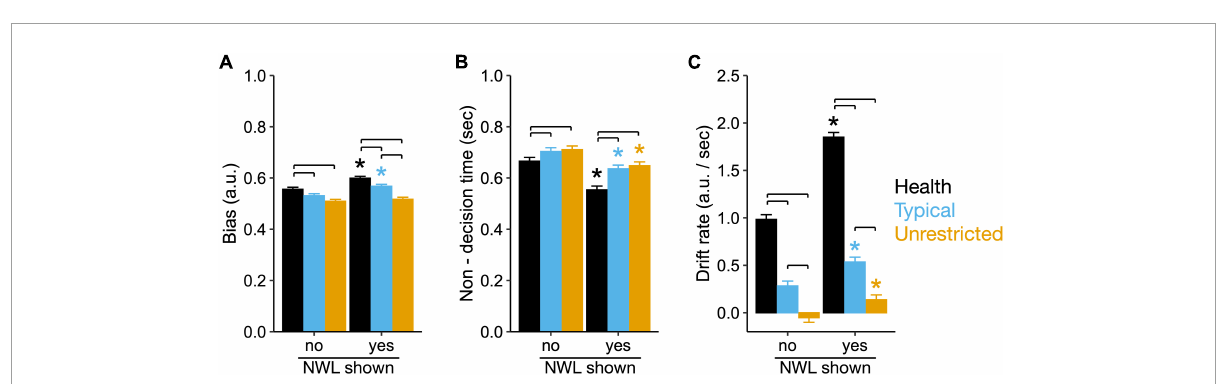
FIGURE5 Eating contexts determine the effect of showing nutrient warning labels (NWL) on the bias, non-decision time, and drift rate during food choice. (A) Bias, (B) Non-decision time, and (C) Drift rate derived from a drift-diffusion model (DDM) considering healthy food choices as the upper boundary for food choices made without showing and then showing NWL. Brackets, P < 0.05 pairwise differences between contexts for choices made with and without showing NWL. Asterisks, P < 0.05 in bias, non-decision time, and drift between choices made with and without showing NWL within